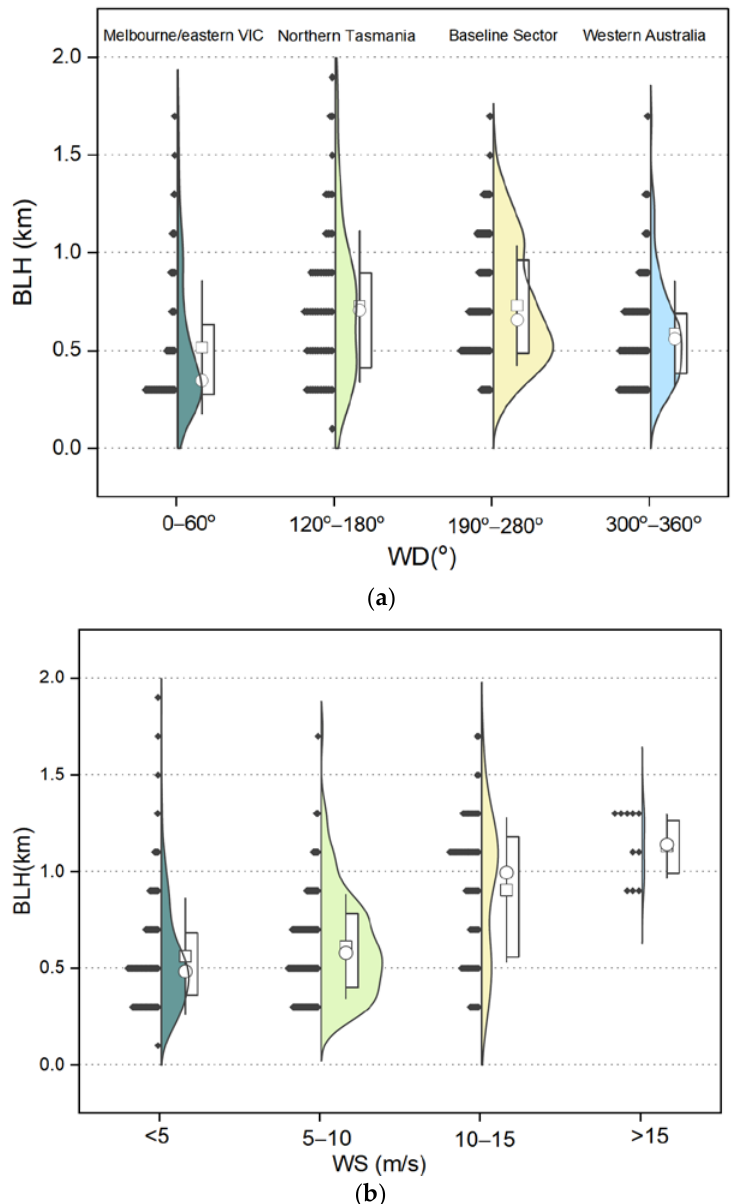
Figure 12. ( a ) Statistical result of BLH (retrieved by IED from the ceilometer) under different sources—Melbourne/Eastern VIC (WD:0–60°), Northern Tasmania (WD:120–180°), Baseline Sector (WD:190–280°) and Western Australia (WD:300–360°), and ( b ) under different wind speeds. The white rectangle and the white circle in the box show the mean and median values, and the upper and lower edges in the white box represent the upper and lower points in the data set. The distribution of observable numerical points is presented on the left half.